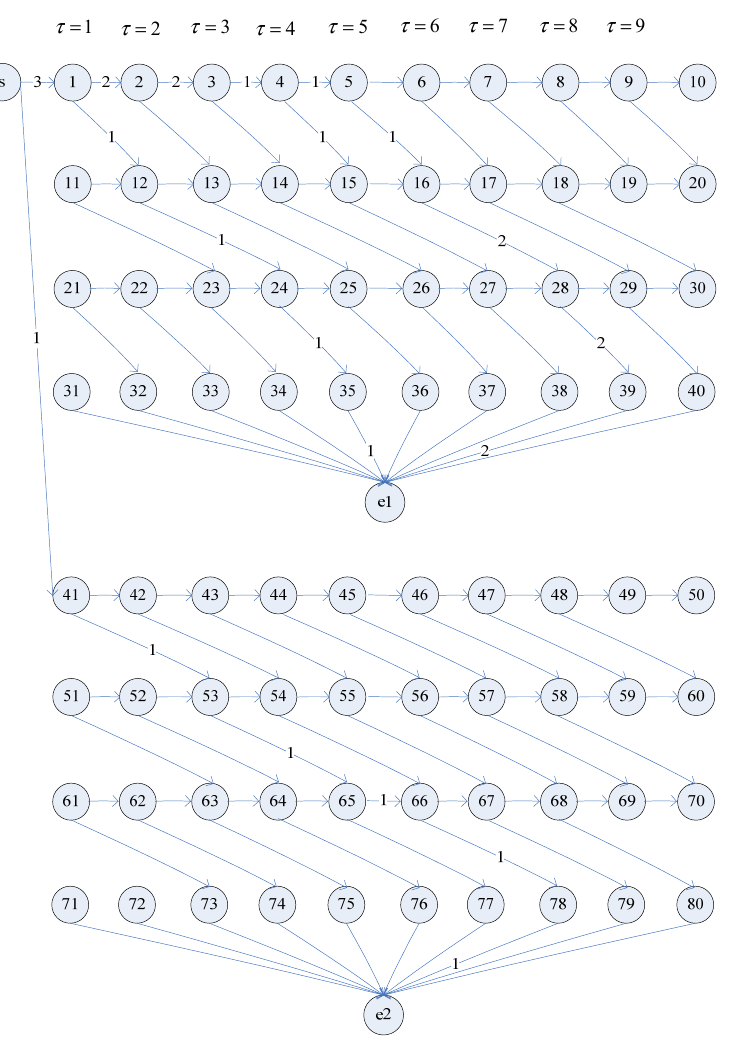
Figure 6. A solution of NOP represented in JSTN.